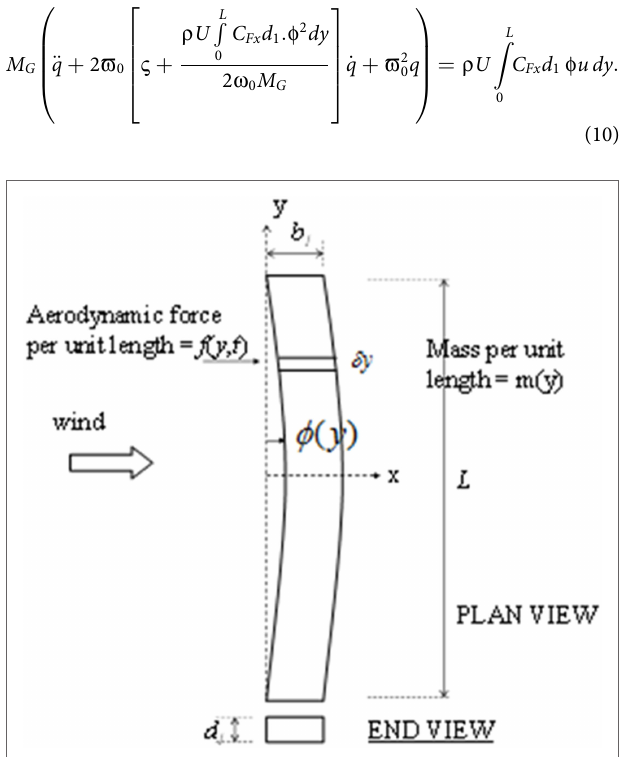
FIGURE 4 | Schematic of flexible line like